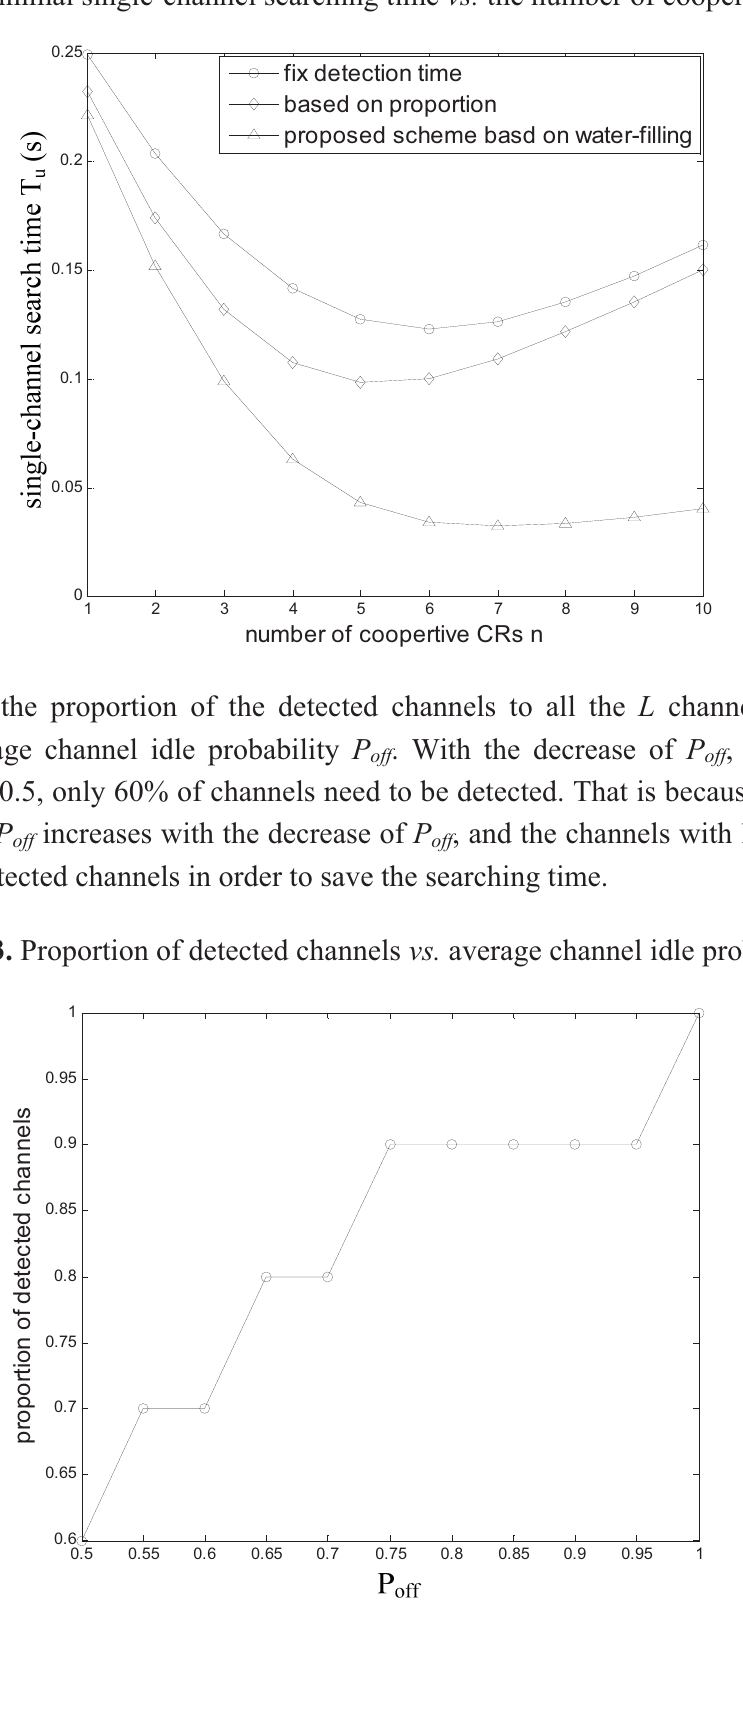
Figure 12. Minimal single-channel searching time vs. the number of cooperative CRUs.